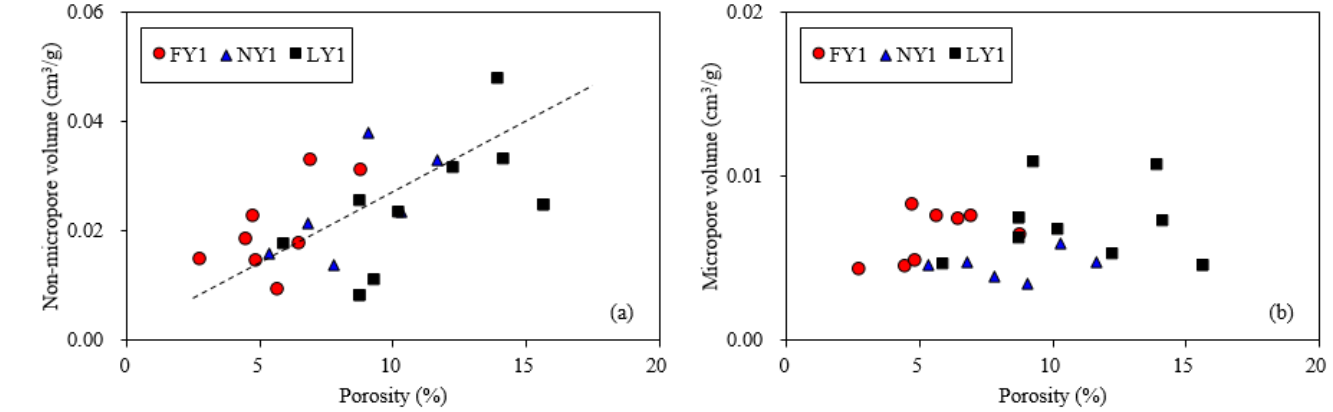
Figure 11. Relationships of porosity with non-micropores ( a ) and micropores ( b ) for the studied samples.